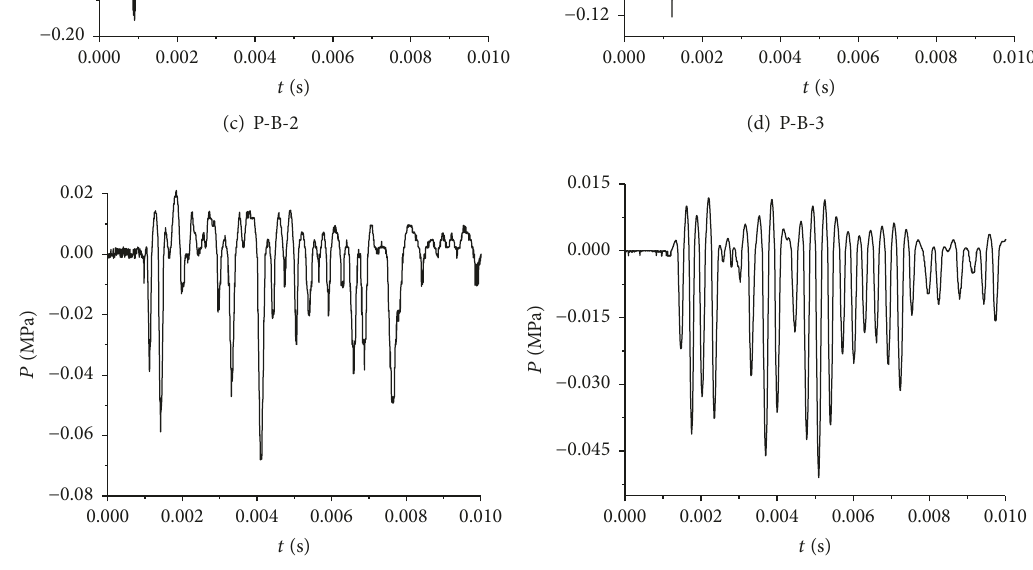
𝐶 : Cohesion of dense sand 𝑊 : Explosive charge quantity 𝑅 : Scaled